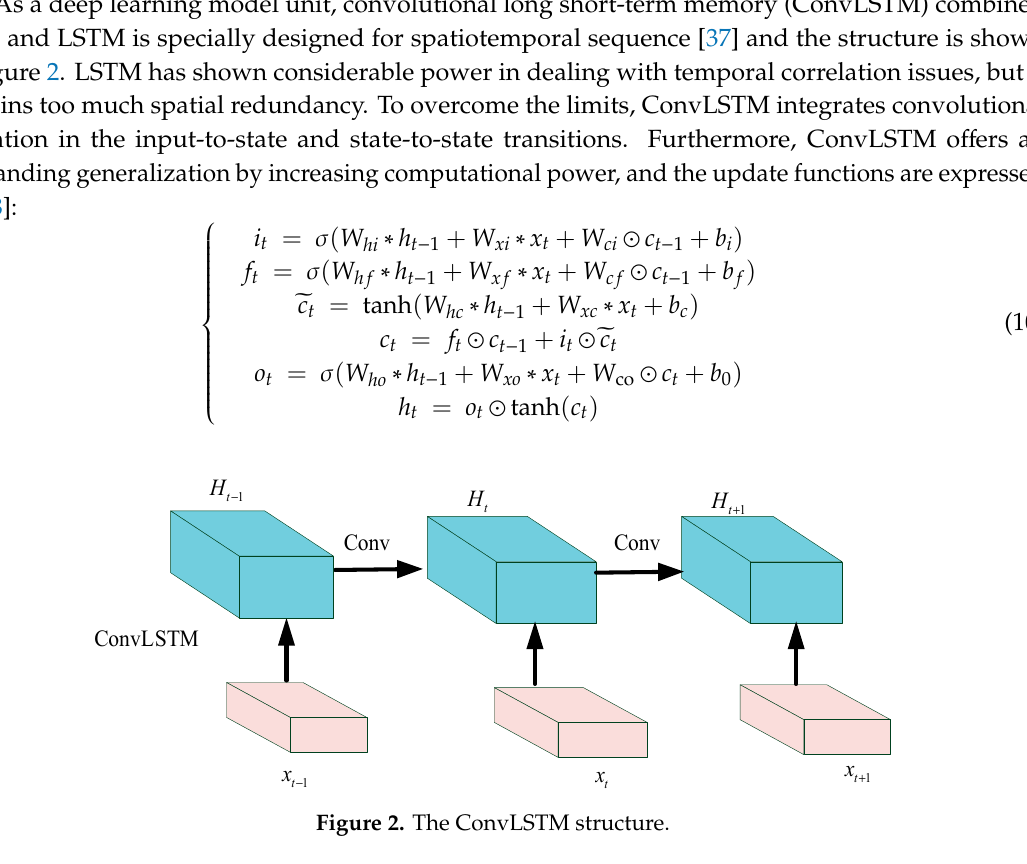
Figure 2. The ConvLSTM structure.